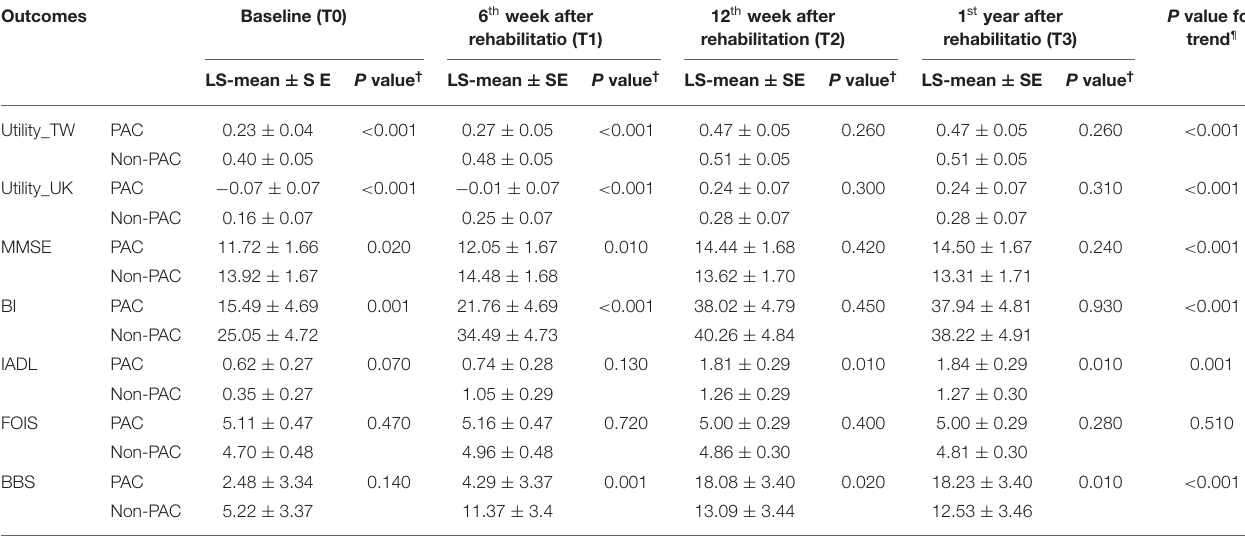
TABLE 2 | Comparison of functional status trends between PAC and non-PAC groups after matching (120:120).